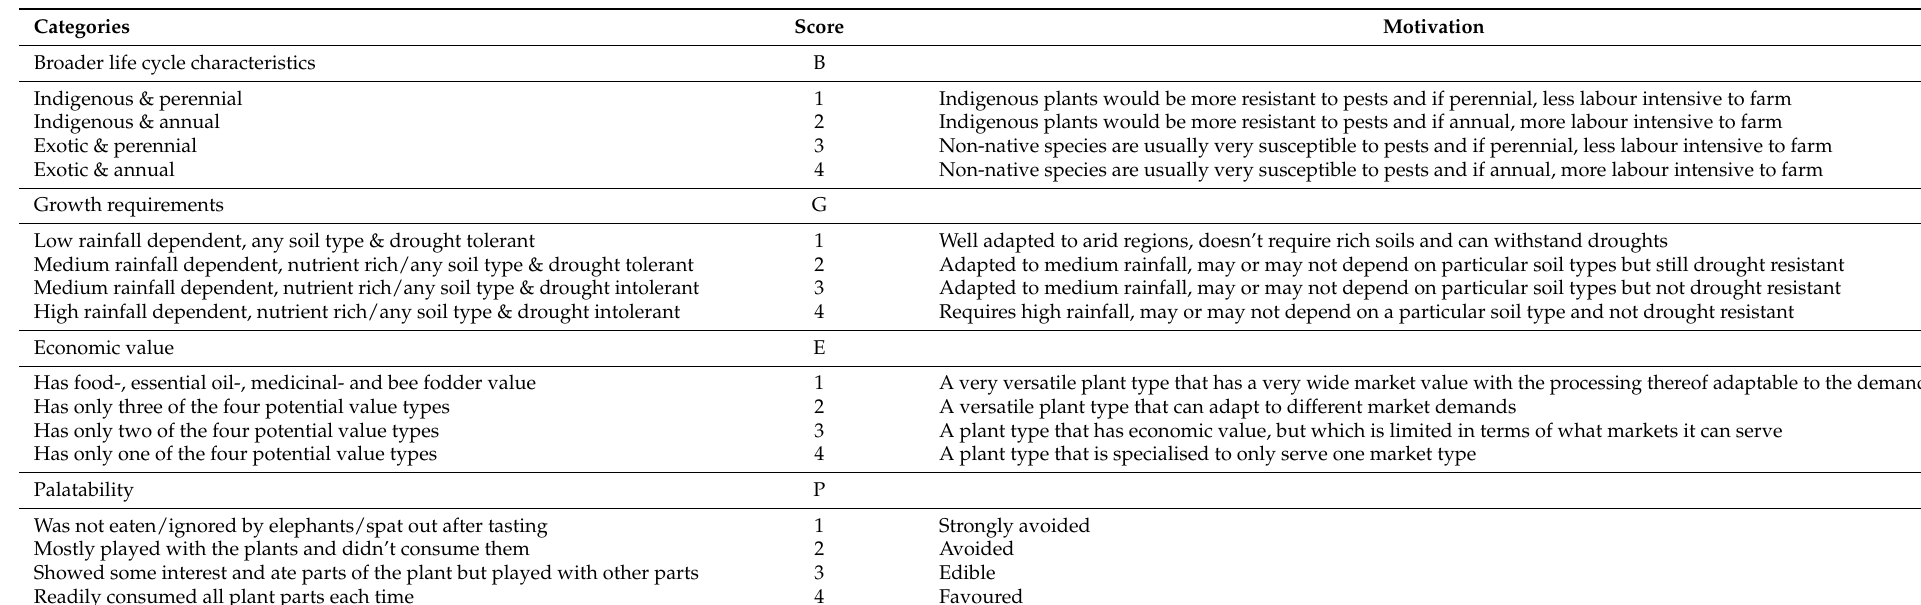
Table 1. The 4-point scoring of each of the chosen plant or crop types according to border life cycle characteristics (B), growth requirements (G), their potential economic value based on the literature (E) and their palatability following the cafeteria experiments (P). The reasoning behind the scores is explained under the